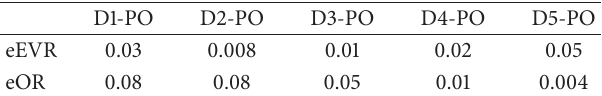
Table 4: Within group comparison of serum bilirubin concentra- tion at each postoperative time point as compared to the PO level. The numbers in the table represent the 𝑃 values (Wilcoxon signed ranks test).